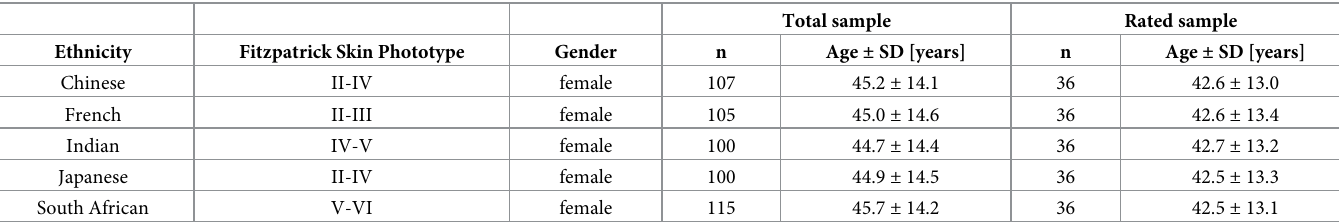
Table 1. Sociodemographic information and skin pigmentation of participants for the total sample and the subsample for the rating study.